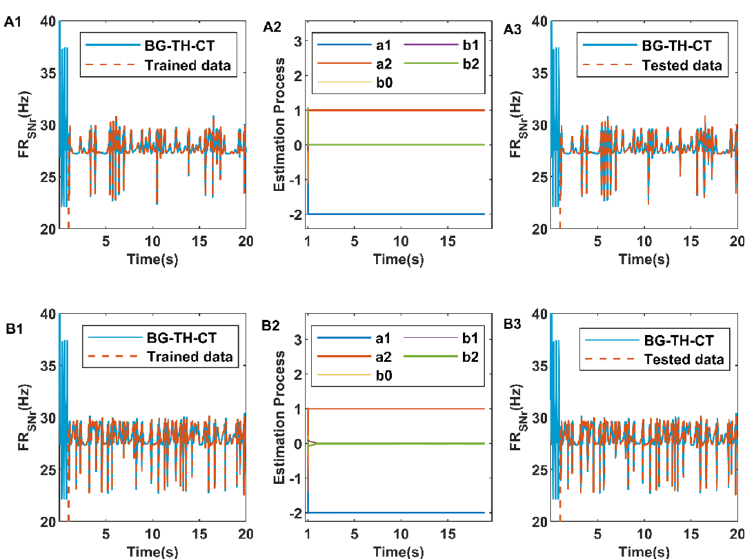
Figure 4. The performance of CAR models in model training ( A1 ), parameter estimation ( A2 ), and model testing ( A3 ) when input of CAR model is DBS current frequency. The performance of CAR models in model training ( B1 ), parameter estimation ( B2 ), and model testing ( B3 ) when input of CAR model is DBS current amplitude. In ( A1 , B1 , A3 , B3 ), the solid blue lines represent data from the basal ganglia-cortical-thalamic model. Dashed orange lines represent training data for CAR models in ( A1 ) and ( B1 ), and test data for CAR models in ( A3 ) and ( B3